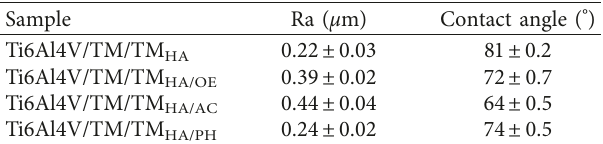
Table 2: Mean values of roughness in the micrometric scale de- termined by contact profilometry for the nonsterilized and the sterilized (by three different processes)